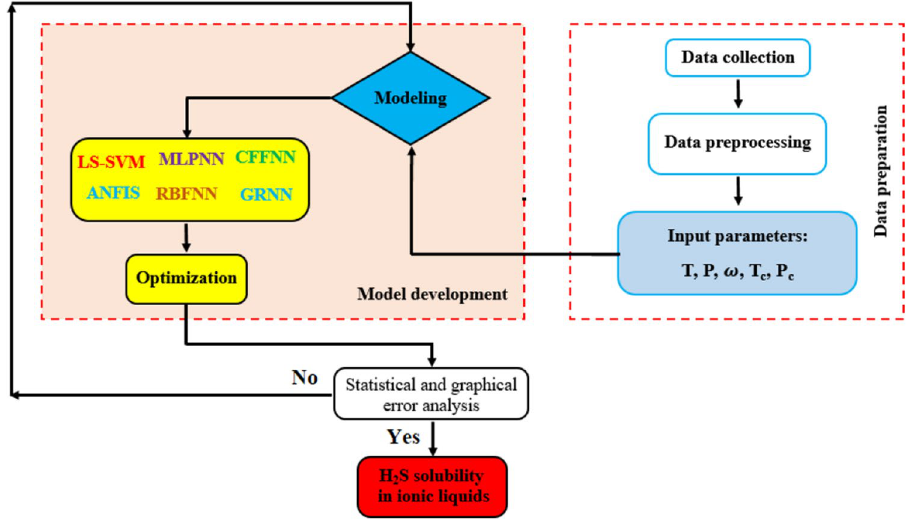
Figure 1. General sketch for development of the proposed models.